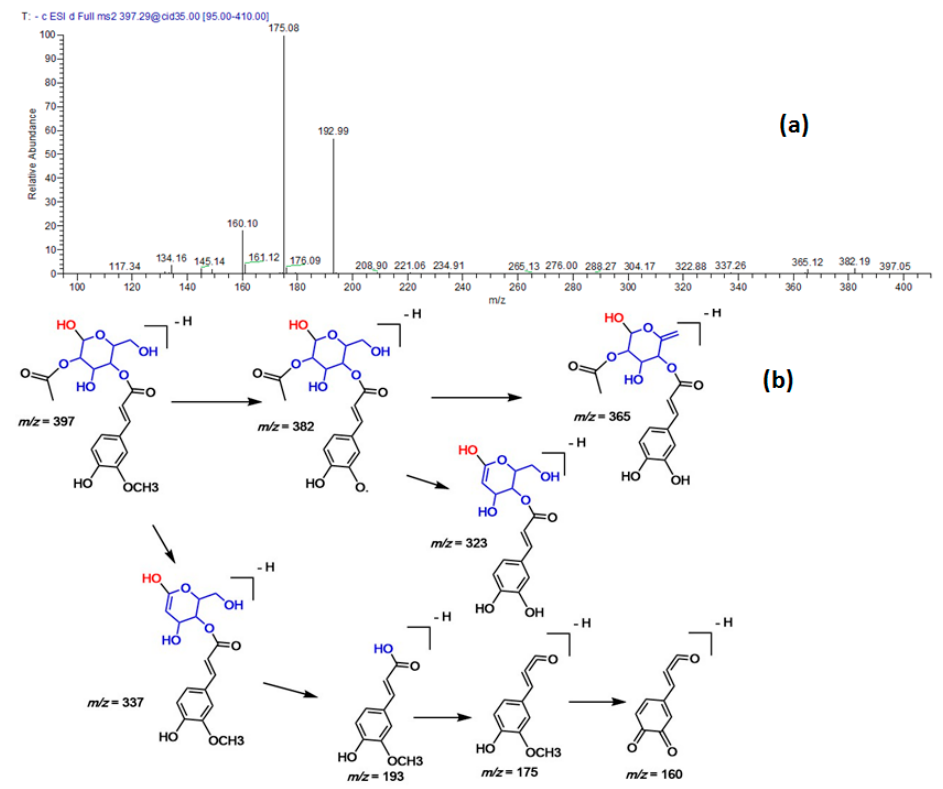
Figure 2. ( a ) MS/MS spectra of ferulic acid acyl-glucoside at [M − H] − m/z 397. ( b ) A proposed fragmentation pattern in the negative ion mode.